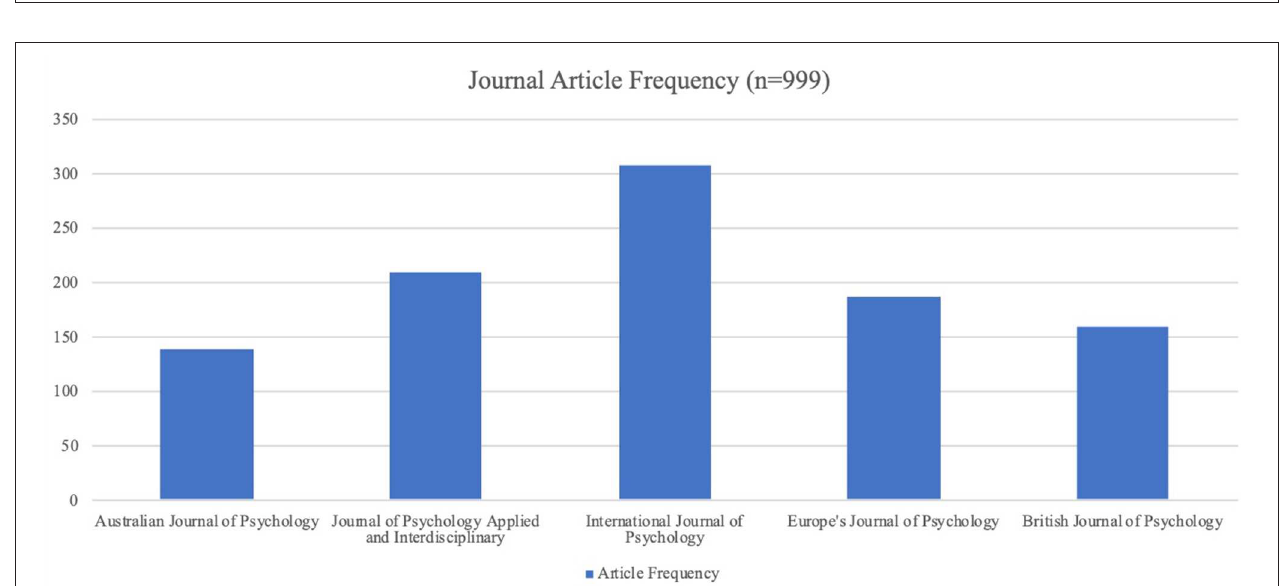
FIGURE 2 | Journal article